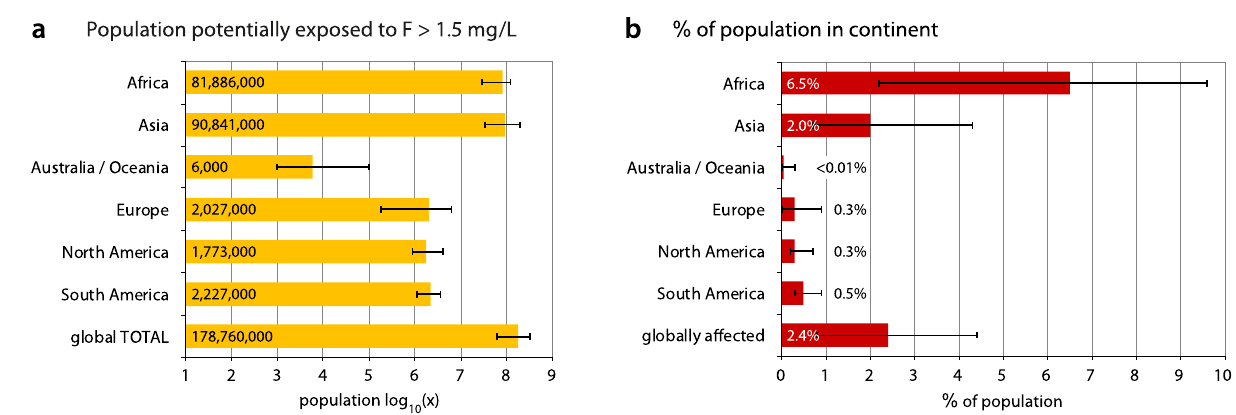
Fig. 3 Population potentially exposed to fl uoride >1.5 mg/L in groundwater. Calculations are made according to the hybrid approach, with a the number of people potentially affected by continent and b the percentage of the total population that this represents. The error bars represent the low and high estimates of affected population